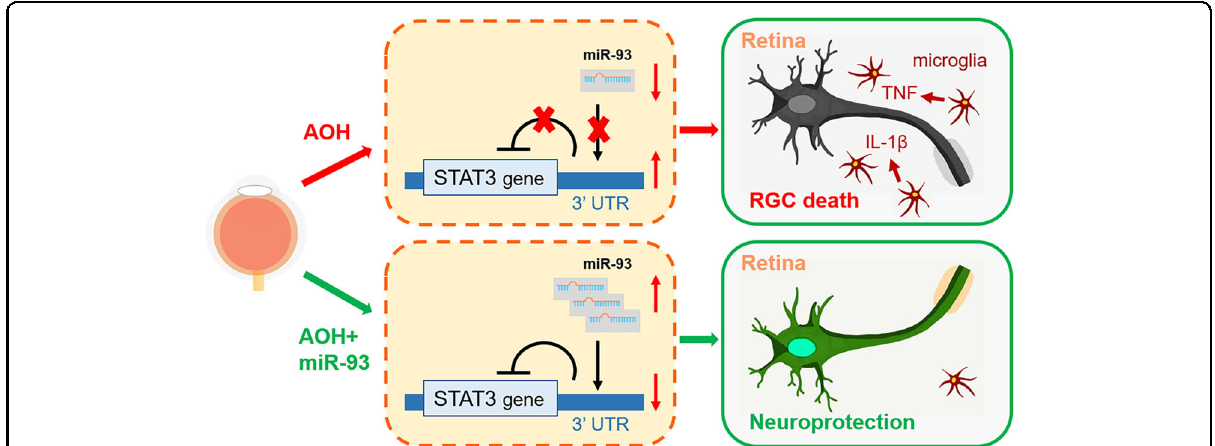
Fig. 6 Graphical summary of the miR-93/STAT3 pathway in AOH injury. In AOH eyes, downregulated miR-93 releases the repression of downstream target genes of STAT3. Retinal microglial cells markedly activate and overproduce in fl ammatory cytokines, ultimately leading to retinal ganglion cell (RGC) death. Supplementation with miR-93 can represses STAT3 by binding to the 3 ′ UTR of STAT3, regulating microglia-mediated neuro-in fl ammation and protecting RGCs against AOH. Thus, miR-93 may serve as a novel target for neuroprotective therapy in